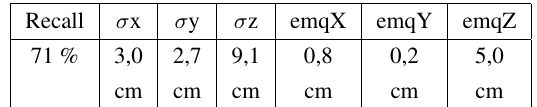
Table 4. Inserting point precision results.